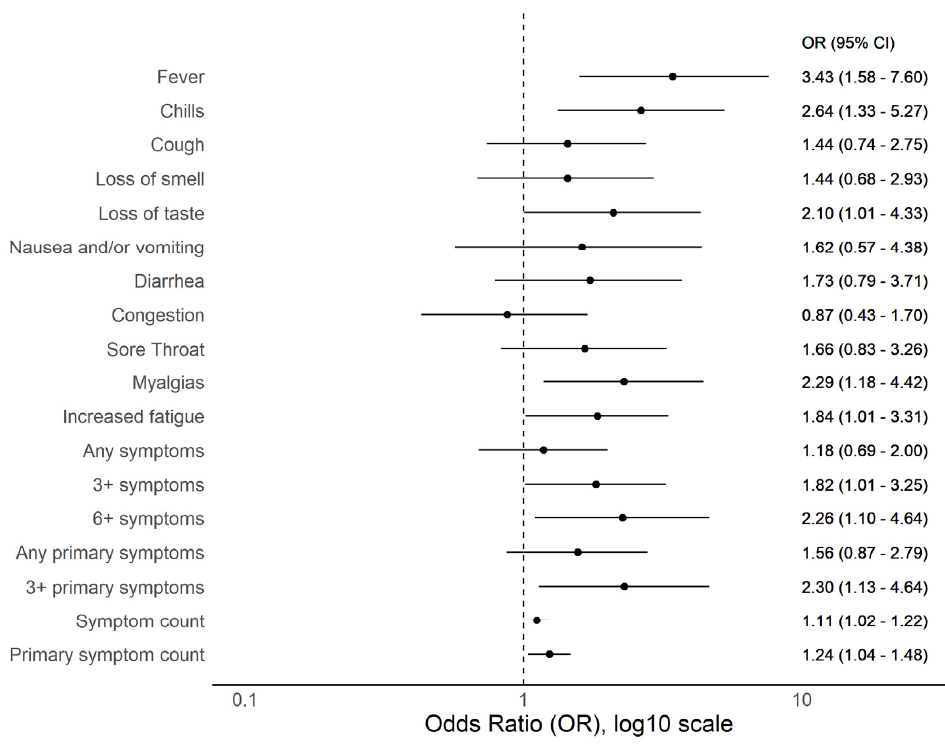
Figure 2. Forest plot of odds ratios of reported COVID-19 compatible symptoms among obese ( n = 85) versus non-obese ( n = 179) SARS-CoV-2 seropositive individuals.